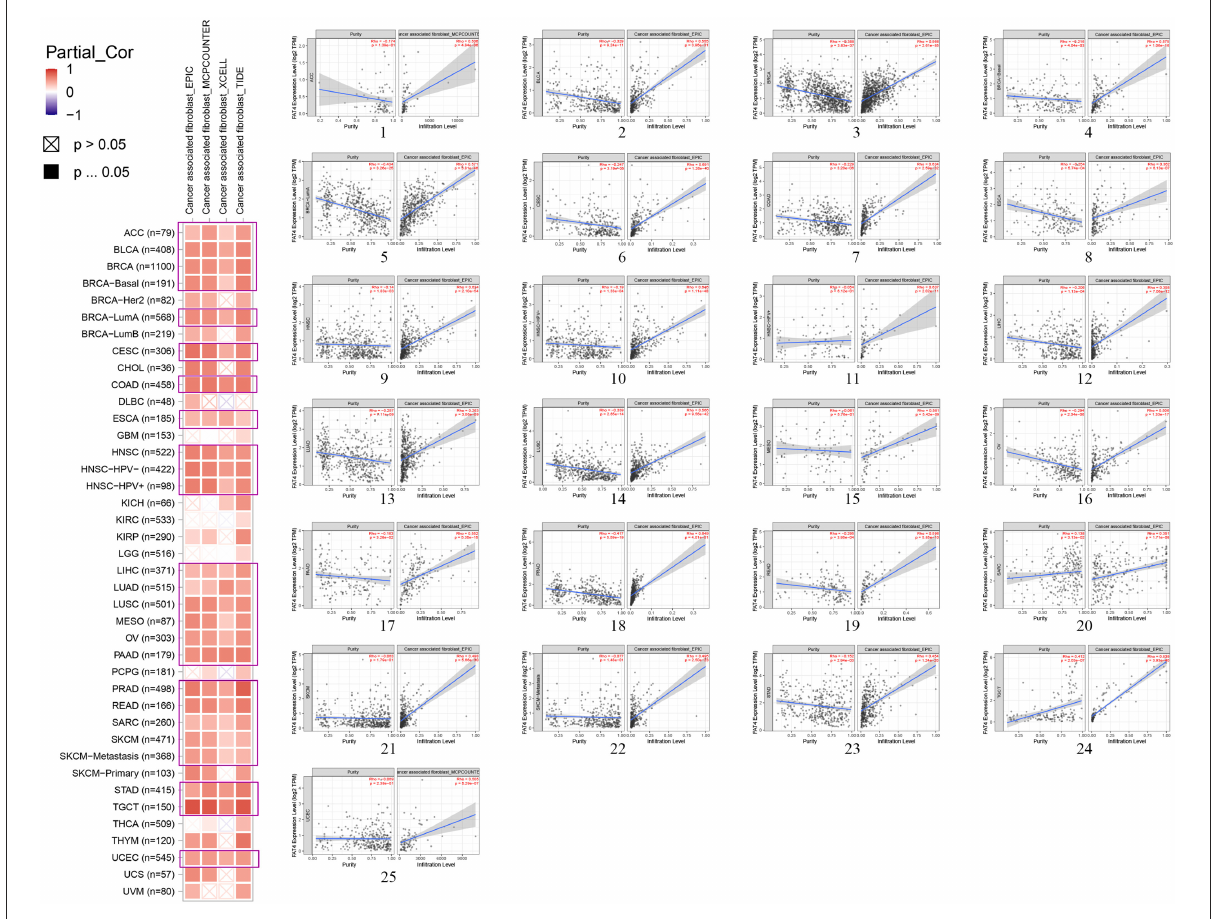
FIGURE6 Correlation analysis between FAT4 expression and immune infiltration of cancer-associated fibroblasts. (1-25) Scatter plots of specific immune infiltration of cancer.